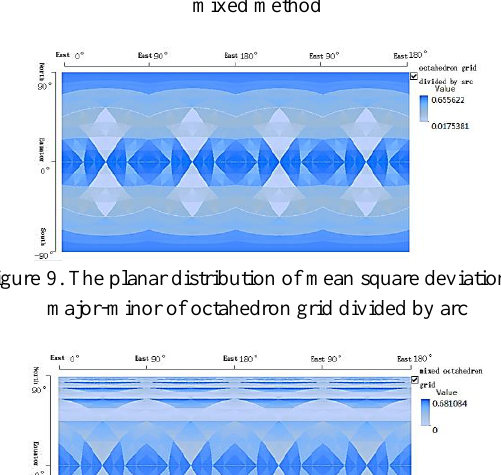
Figure 3. Major-minor axis ratio